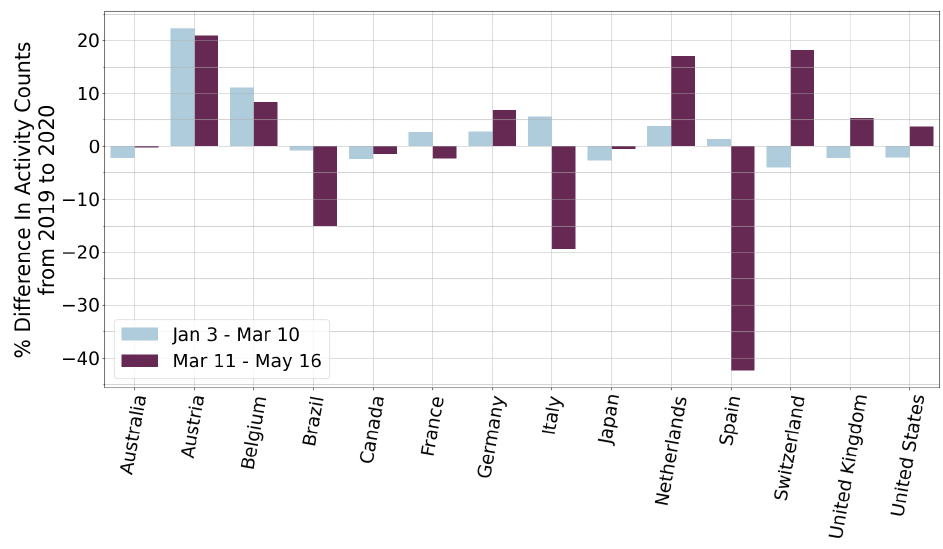
Figure 3. Percent difference in activity counts from 2019 to 2020 compared for the 67-day periods before and after the 11 March World Health Organization (WHO) pandemic declaration date.